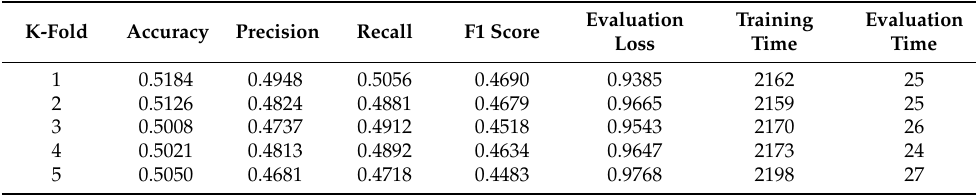
Table 16. BERTimbau—PorSimples Corpus dataset.